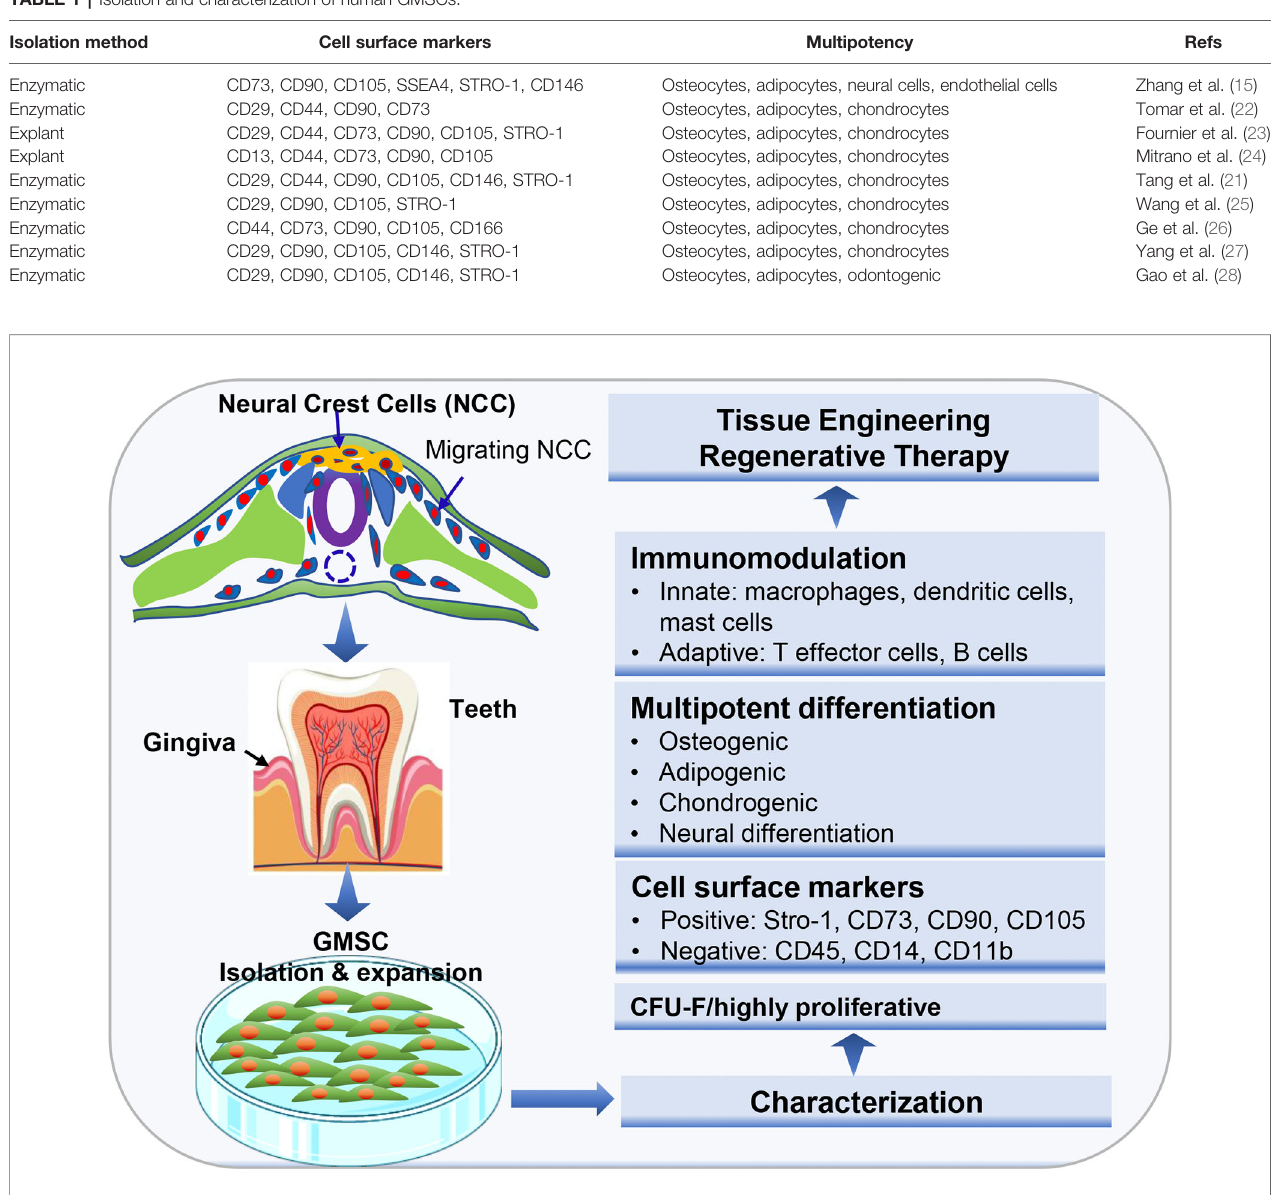
FIGURE 1 | Isolation and characterization of mesenchymal stem cells derived from gingival tissues of neural crest origin. A unique subpopulation of mesenchymal stem cells can be isolated from neural crest-derived gingival tissues (GMSC), thus representing a reservoir of neural crest-derived MSCs. CFU-F, colony forming unit- fi broblast. Portions of this fi gure were made using templates from SMART SERVIER MEDICAL ART (https://smart.servier.com) and Vecteezy (https://www. vecteezy.com).